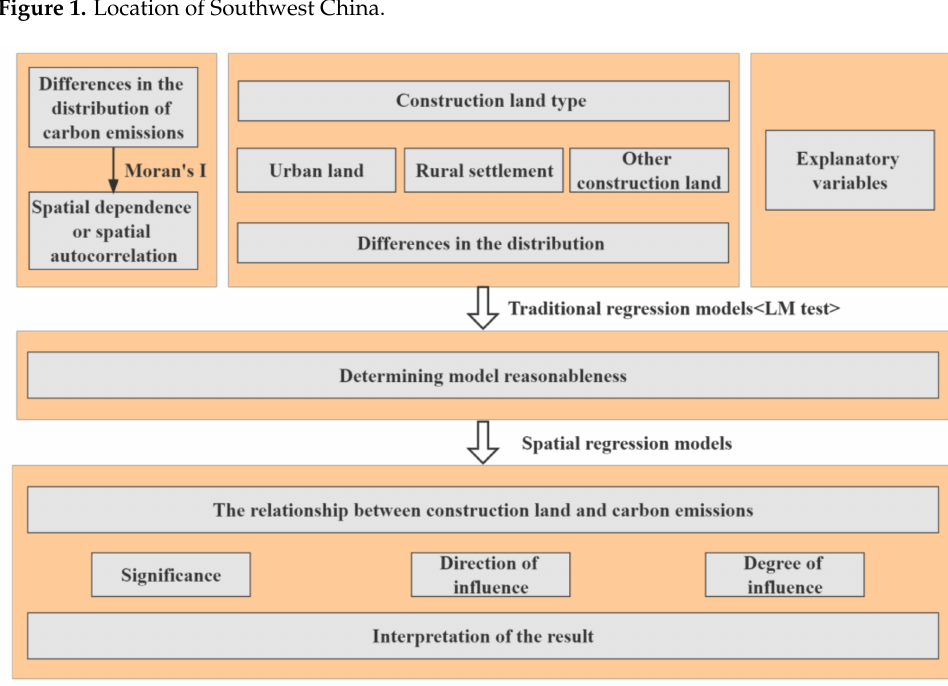
Figure 2. General research